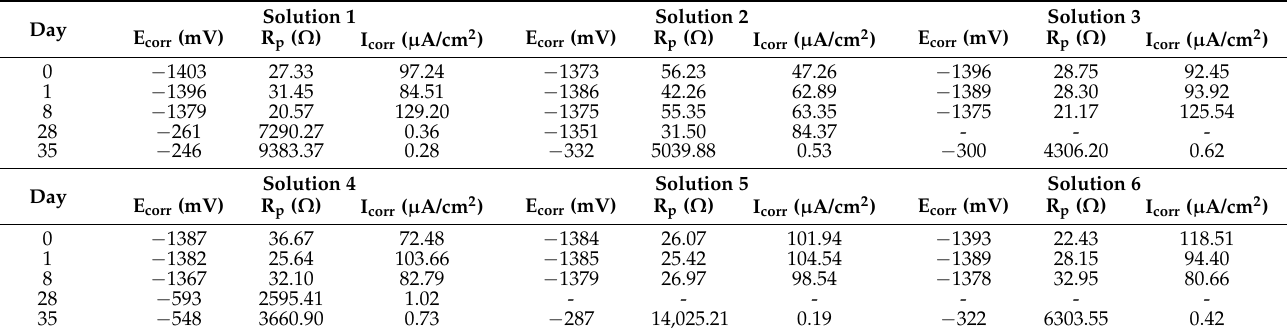
Table 2. Electrochemical parameters obtained after 35 days of manufacture.